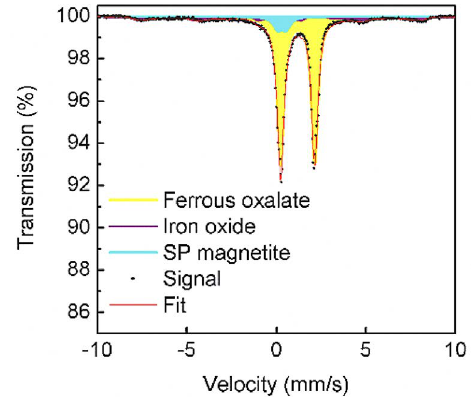
Figure 1. Mössbauer spectrum of